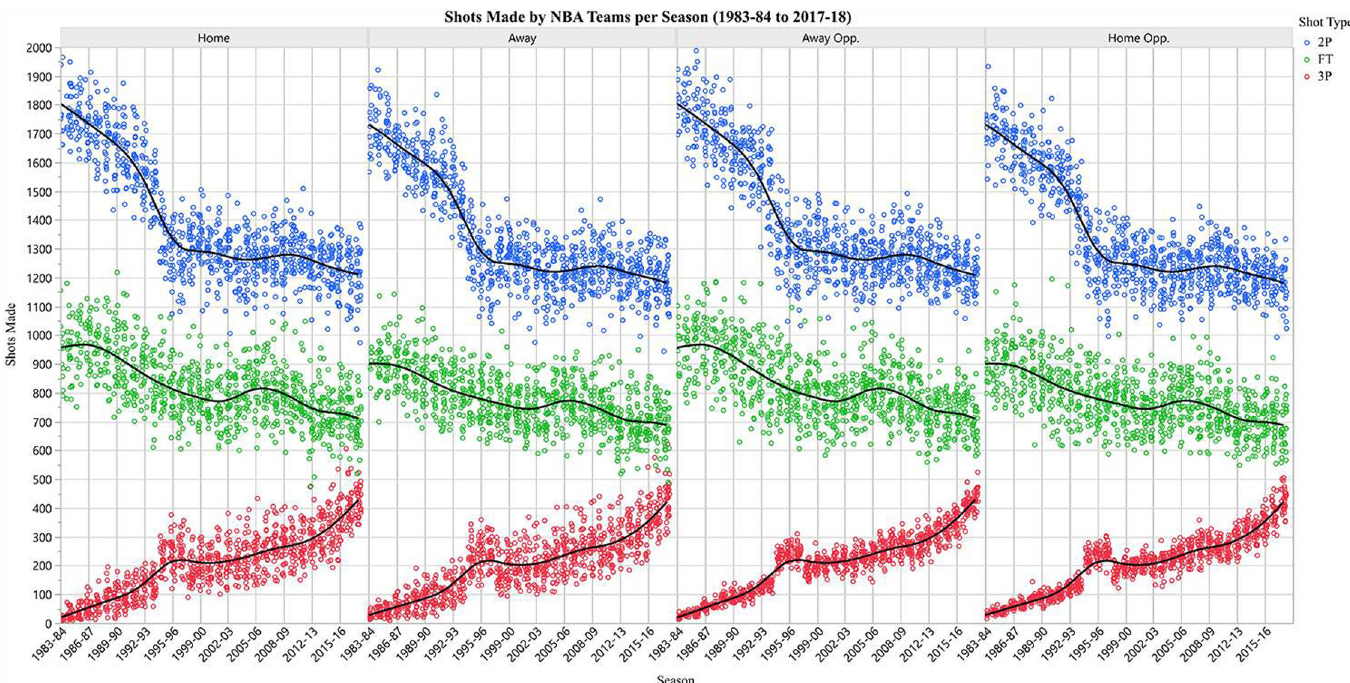
Fig 3. Twelve ANN inputs over time. 2-point (blue), free throws (green), and 3-point (red) shots made by the team at home (Home), their opponent at home (Home Opp), the team away (Away), and their opponent away (Away Opp).